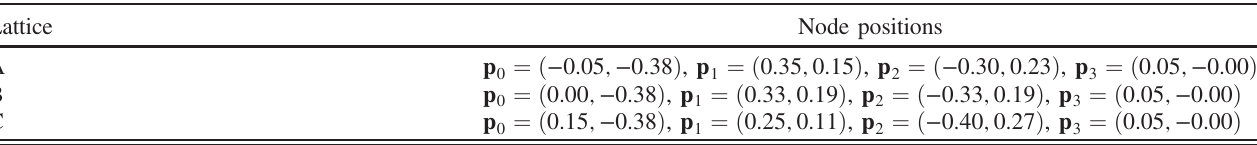
TABLE I. Unit cell descriptions of distorted martini lattices. Labels refer to the lattices in Fig. 2. The position of the nodes [labeled in Fig. 5(a)] is specified in units of the lattice constant a ; the primitive vectors and link connectivity are unchanged. Lattice Node positions